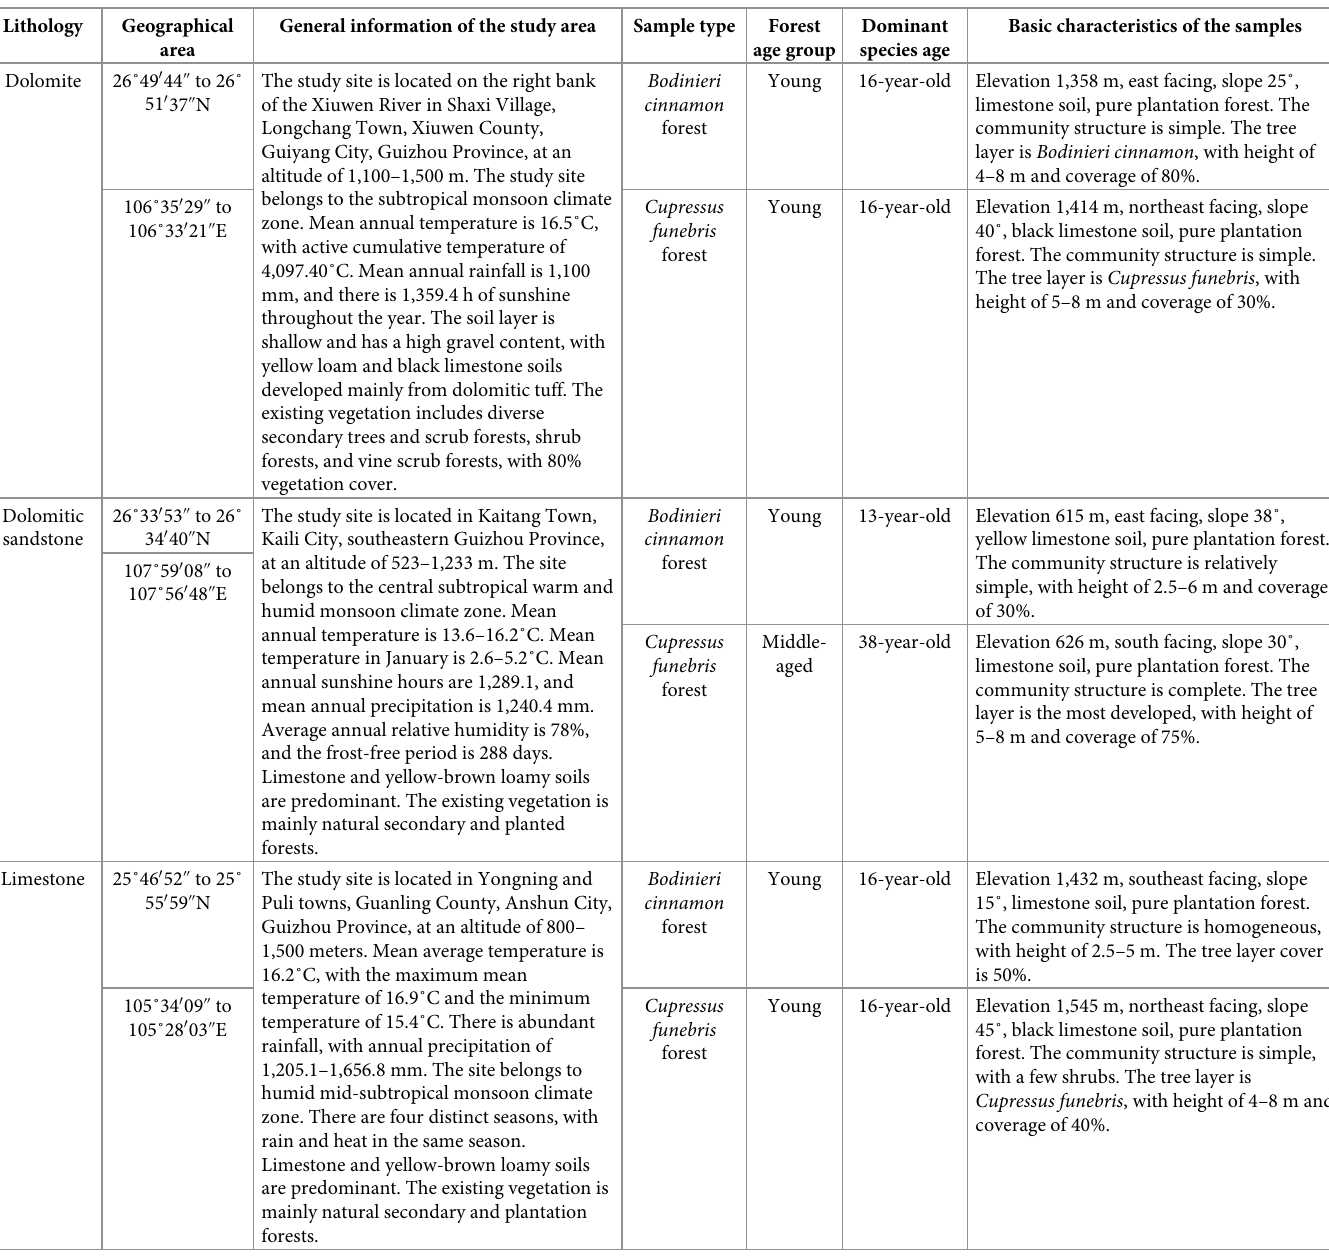
Table 1. Basic overview of the sample